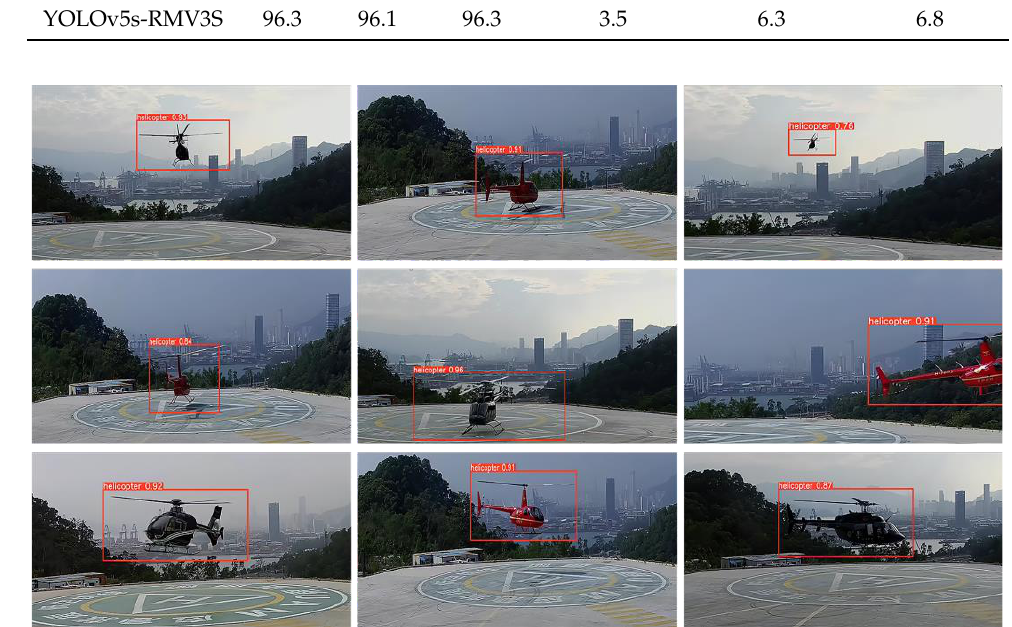
Figure 8. Some of the detection results of the algorithm in this paper.